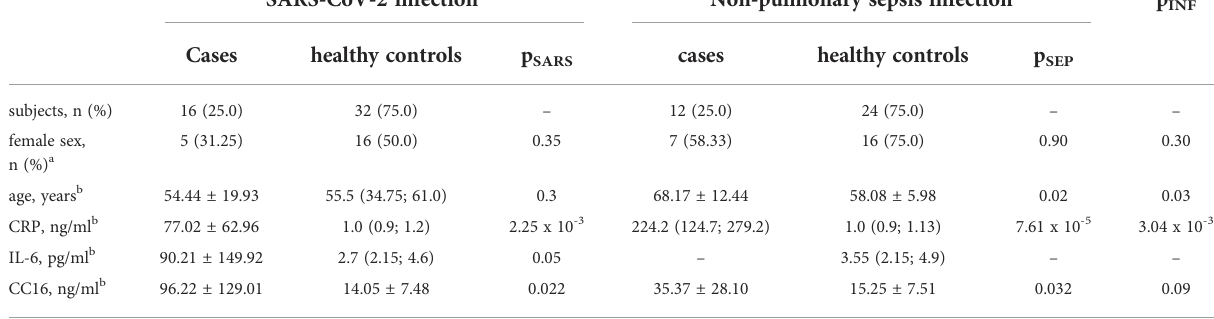
TABLE 1 Characterization of the study